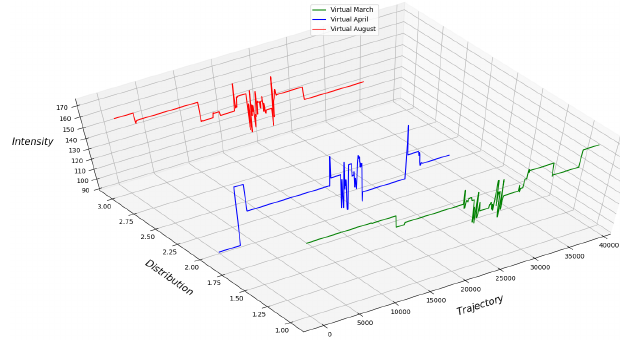
Similarities between measurements are captured in a trajectory specific data-set Φ ( DV → AG ) as described in Figure 14. Virtual probable light signatures for trajectory (II) equation 4. ≥ 0 . 7 Timis oara to Deva with SL=30 and ρ k , The selected predefined SL is 20 segments and after considering the algorithm for matching light patterns between measurements, the results are saved in table 9. With changing baseline between distributions shapes are represented in figure to Pites ti (via Sibiu) segment of A1-DN7, is measured , and analyzed.